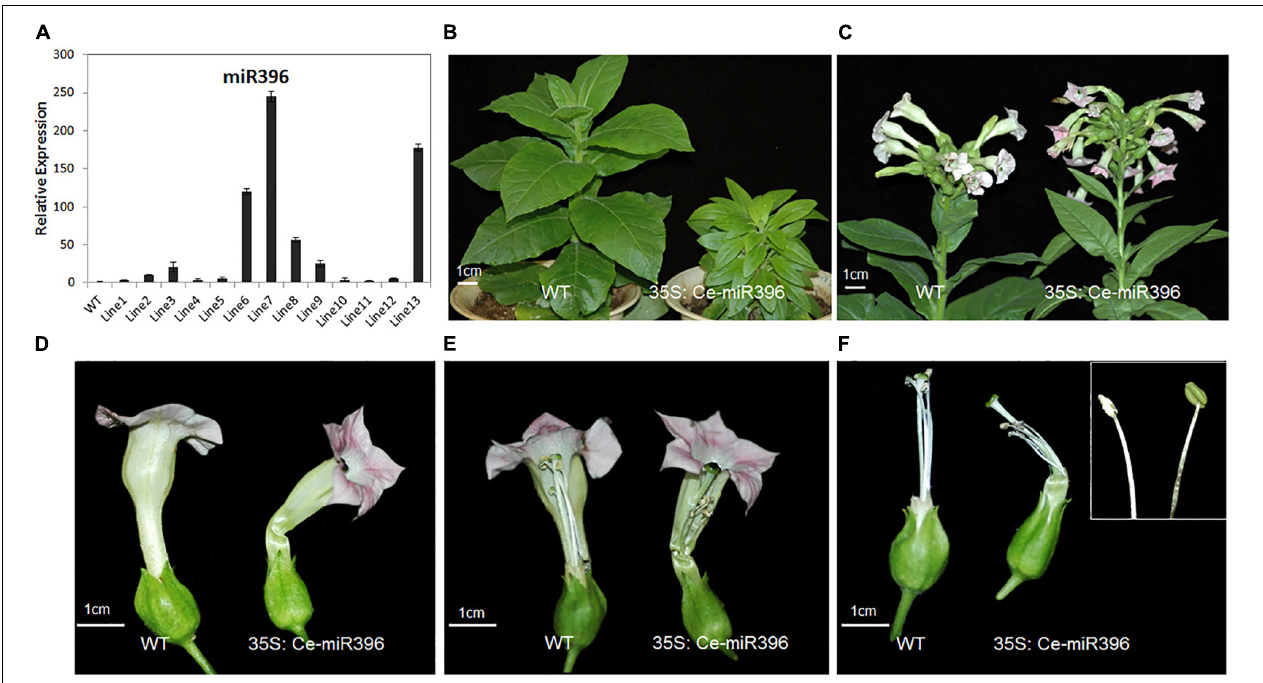
FIGURE 8 | Phenotypes of Flowers Overexpressing Ce- miR396 in Tobacco Plants. (A) Increased expression level of Ce- miR396 in the transgenic lines. The Y-axis indicates fold change in expression between the wild-type and transgenic plants. Expression levels were normalized using the threshold cycle values obtained for the Ubiquitin gene. Error bars indicate the standard deviation of the mean (SD) ( n = 3). Three replicates were analyzed, with similar results. (B) Reduced height and leaf size observed in transgenic plants. (C–F) Comparison of WT and transgenic flower inflorescence (C) , perianth (D) , pistils (E) , and filaments (F) . Bar = 1